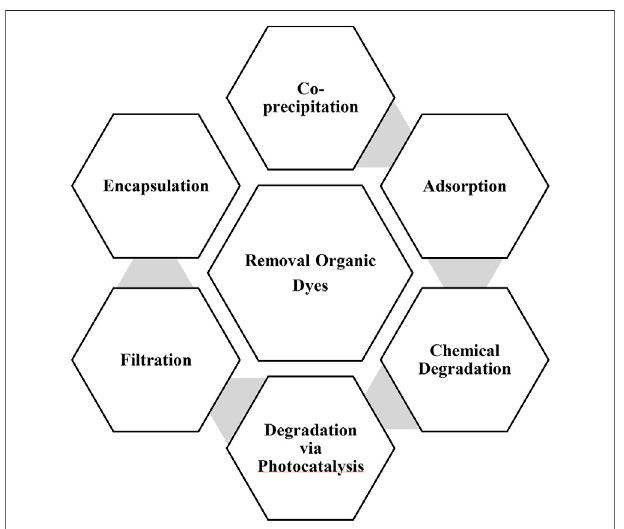
FIGURE 6 | Methods used for removal of organic